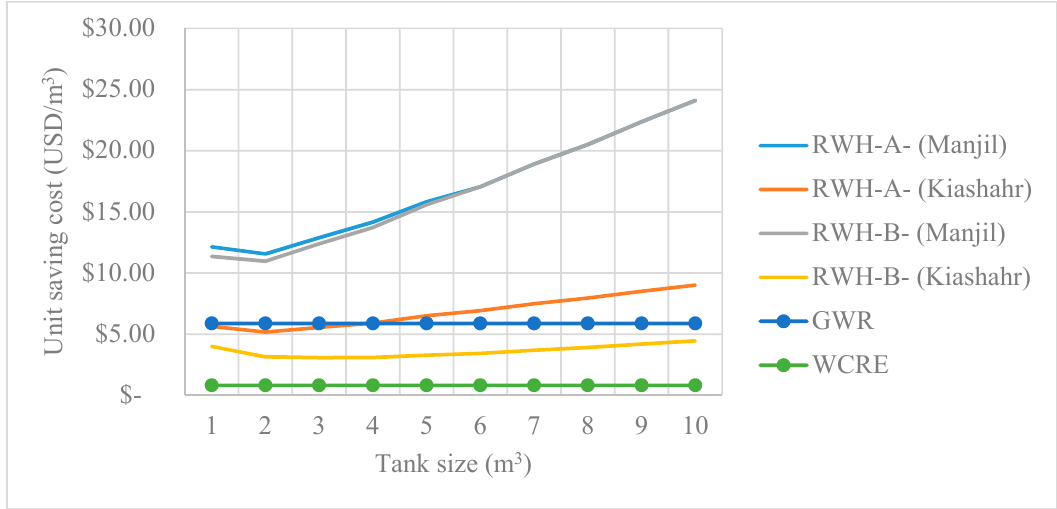
Figure 9. The USC of two stations, Manjil and Kiashahr, with Scenarios A and B and that of WCRC and GWR.